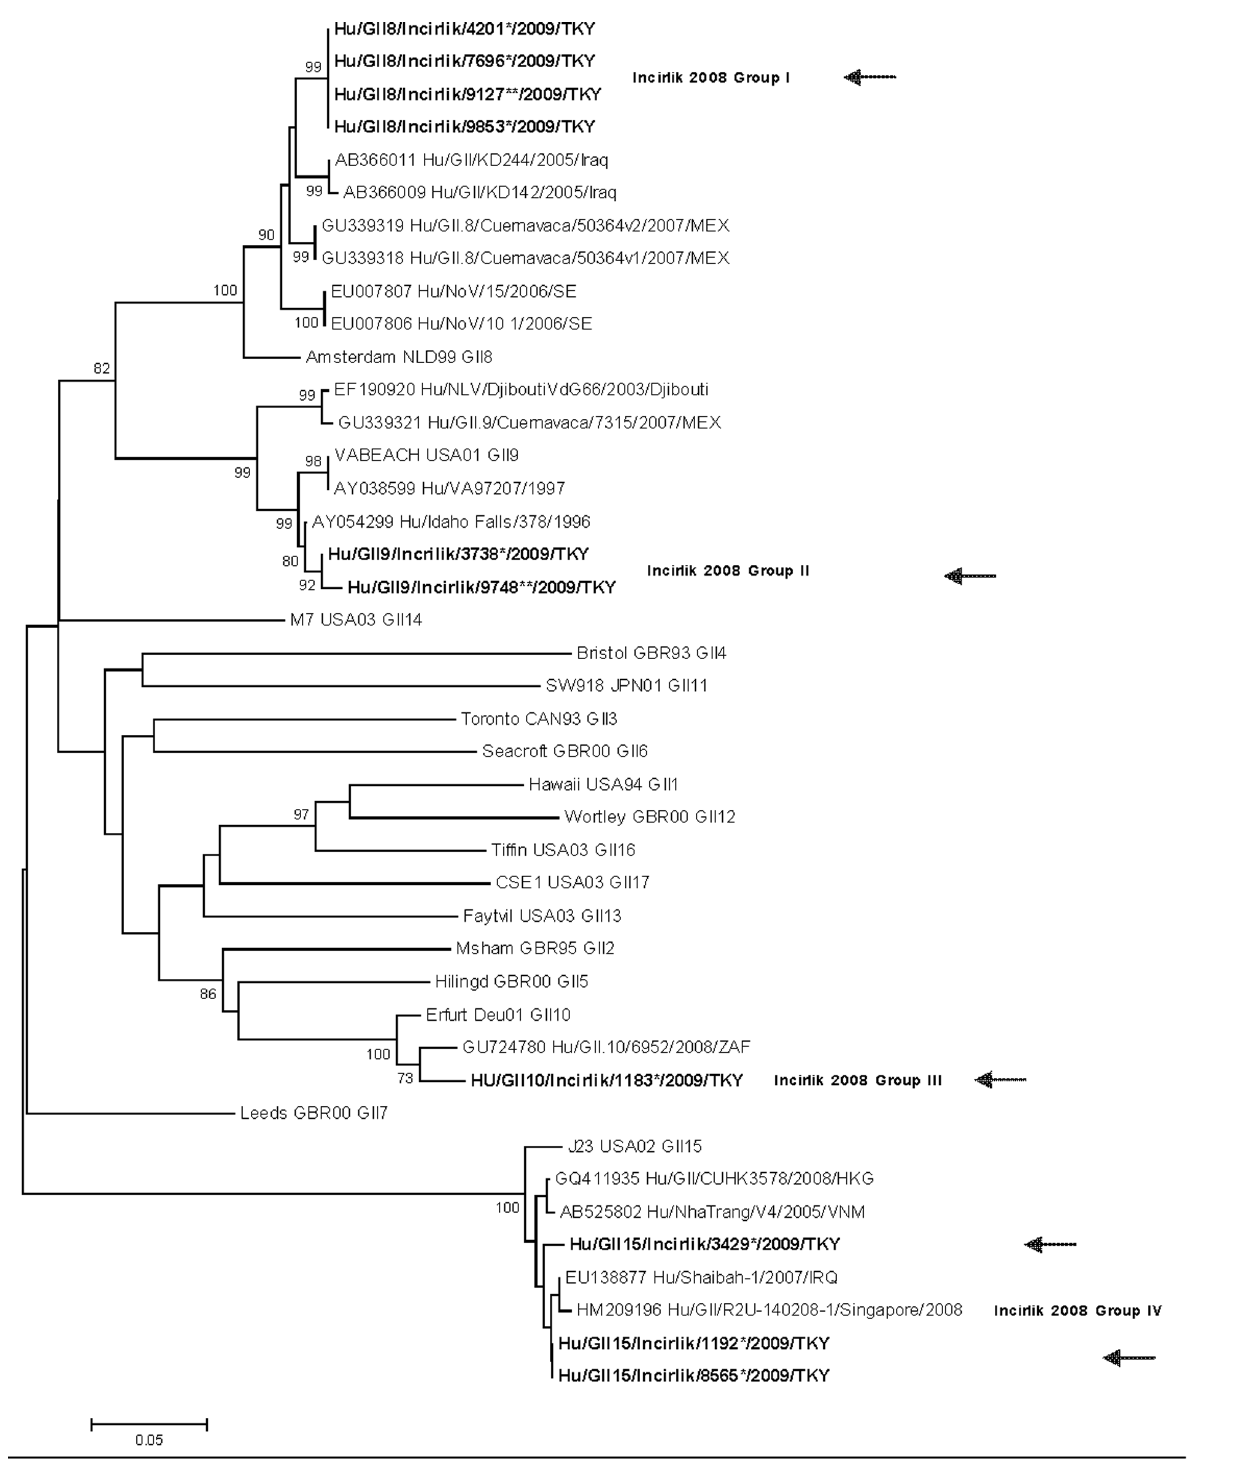
Figure 2. The evolutionary history was inferred using the Neighbor-Joining method. The optimal tree with the sum of branch length =2.38 is shown. The percentage of replicate trees in which the associated taxa clustered together in the bootstrap test (2000 replicates) are shown next to the branches. Boot strap values below 70% were considered insignificant and are not shown. The tree is drawn to scale, with branch lengths in the same units as those of the evolutionary distances used to infer the phylogenetic tree. The evolutionary distances were computed using the Kimura 2-parameter method and are in the units of the number of base substitutions per site. The analysis involved 42 nucleotide sequences. Codon